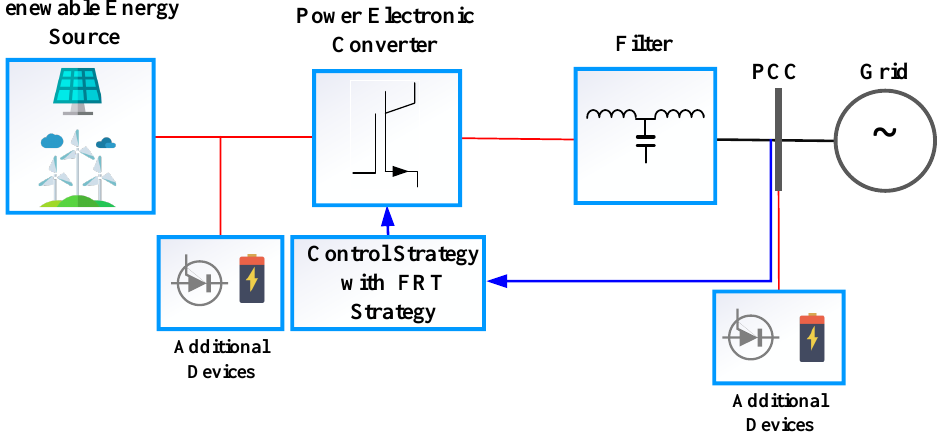
Figure 12. Illustration of a PEC-interfaced renewable energy sources (RES) with different fault ride-through (FRT) options.